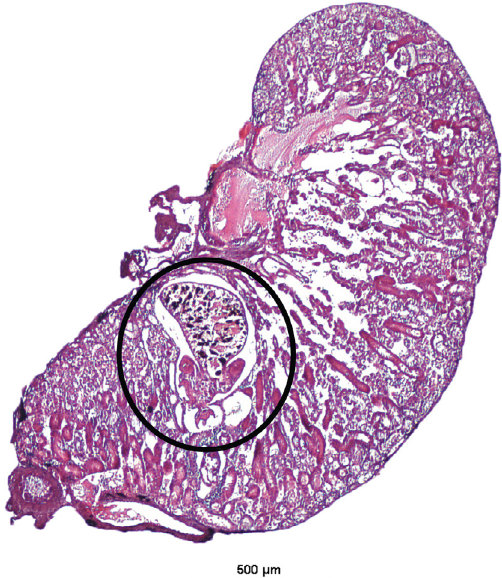
Figure 3. Histological section through a Protopolystoma xenopodis within the kidney of a Xenopus laevis specimen. The position of the parasite is indicated in the